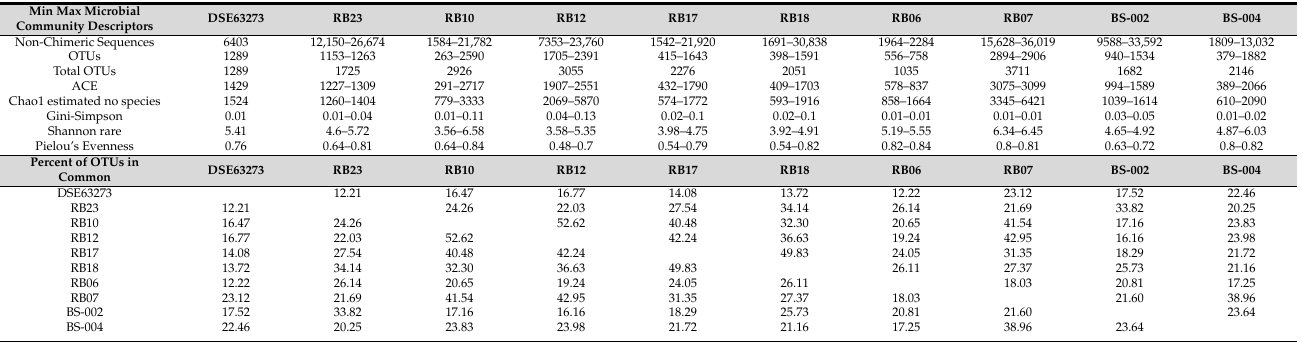
Table 3. The richness, diversity and evenness estimators and the percentage commonality of OTUs between